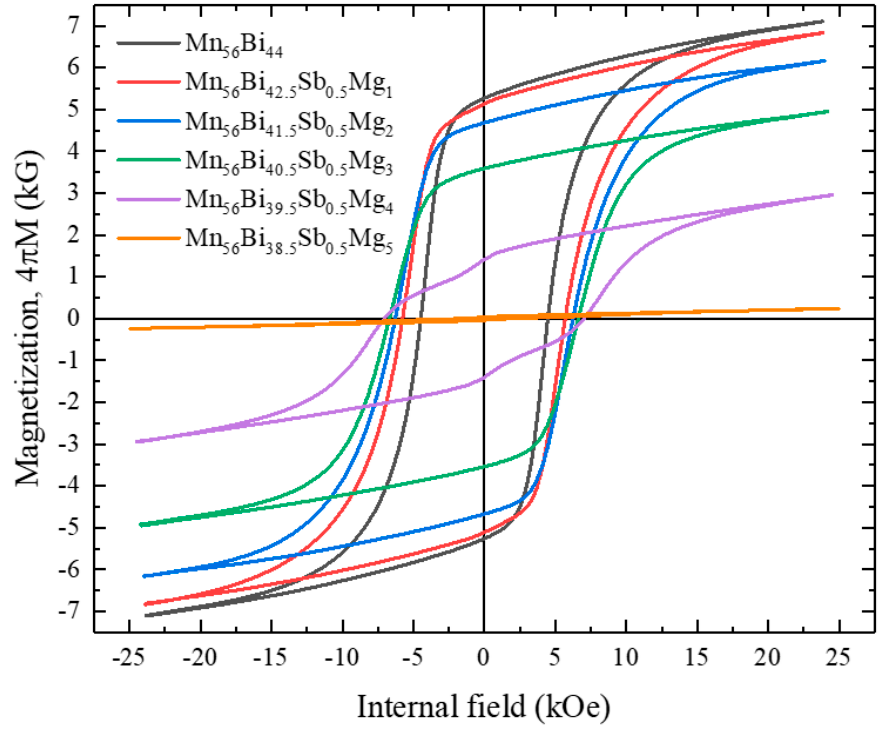
Figure 7. Magnetic hysteresis loops of Mn 56 Bi 43.5 − x Sb 0.5 Mg x (0 ≤ x ≤ 5) bulk samples.